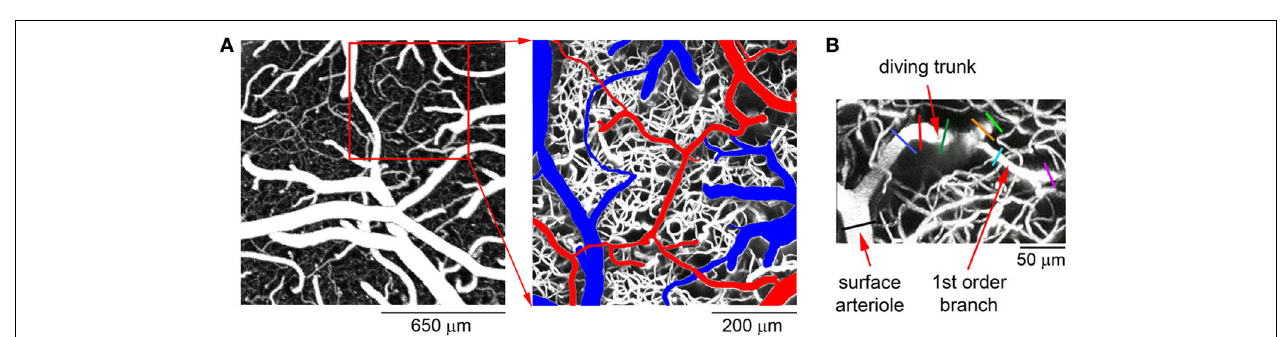
FIGURE 2 | A typical example of the cortical microvasculature. (A) Left: an image of the cortical microvasculature calculated as a maximum intensity projection (MIP) of an image stack 0–300 µ m in depth using a 4 × objective. Individual images were acquired every 10 µ m. Right: a detailed view of the regionwithinthedersquareontheleft.Surfacearteriesandveinsareindicated